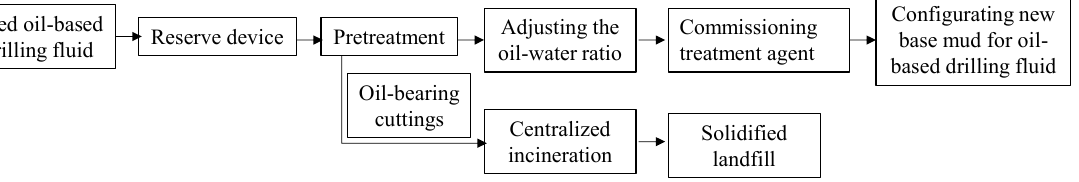
Figure 5. Reuse treatment process of oil-based drilling fluid after well completion.